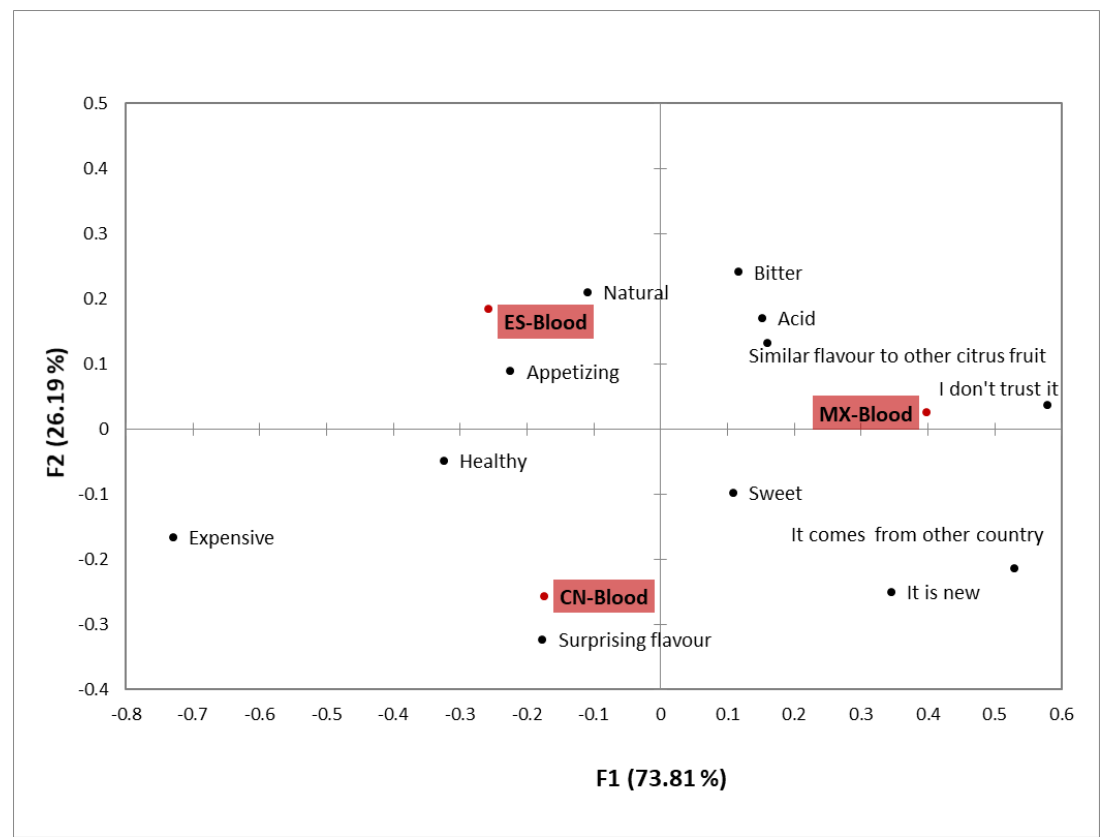
Figure 4. Correspondence analysis for consumers’ expectations. The data used to perform the analysis were the percentage of participants (of those who stated that blood oranges are not available in their habitual shopping place) who selected each expectation. ES — Spain, CN — China and MX — Mexico.